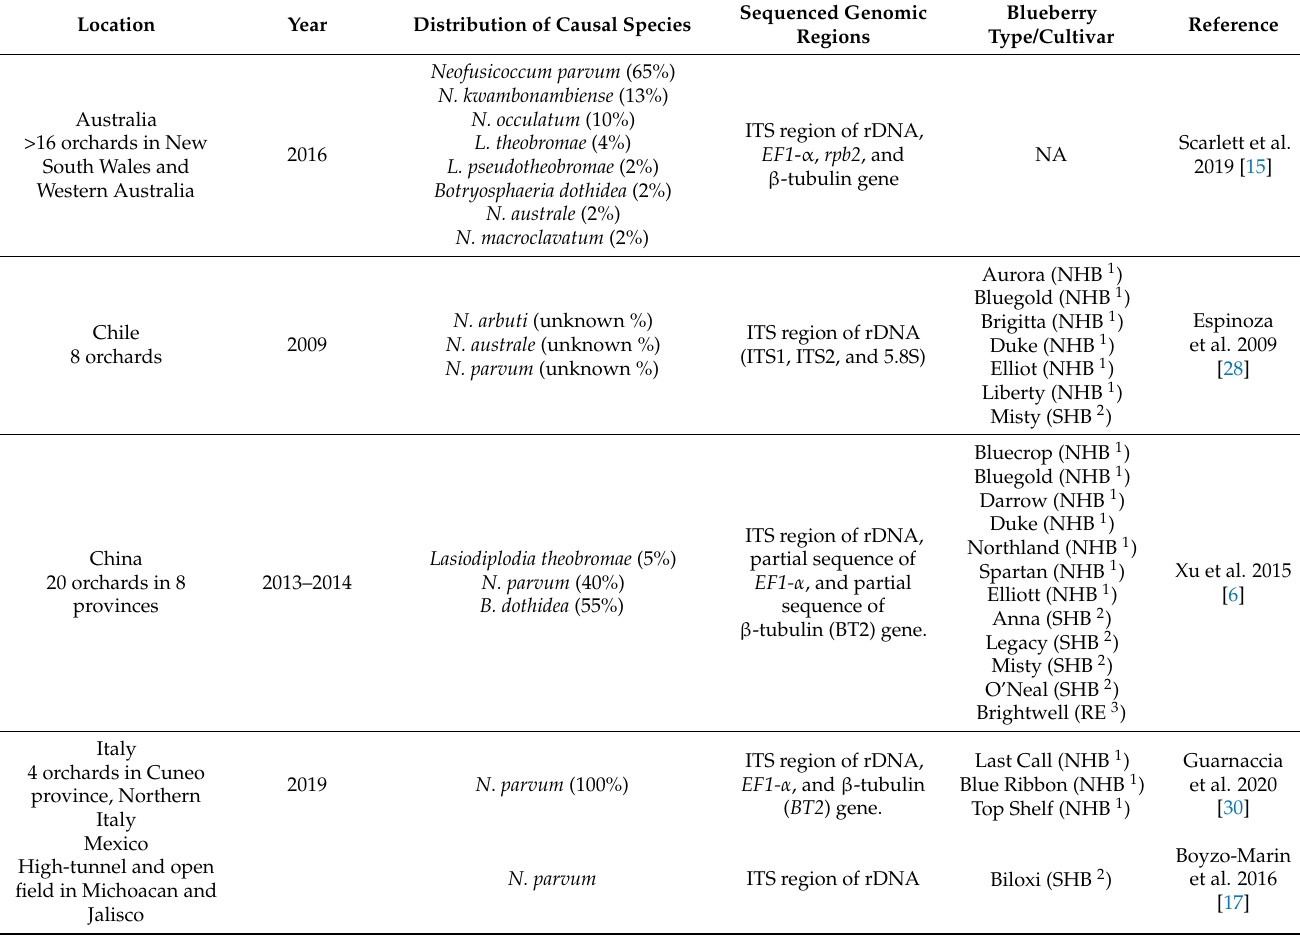
Table 1. Common species of Botryosphaeriaceae associated with blueberry stem blight